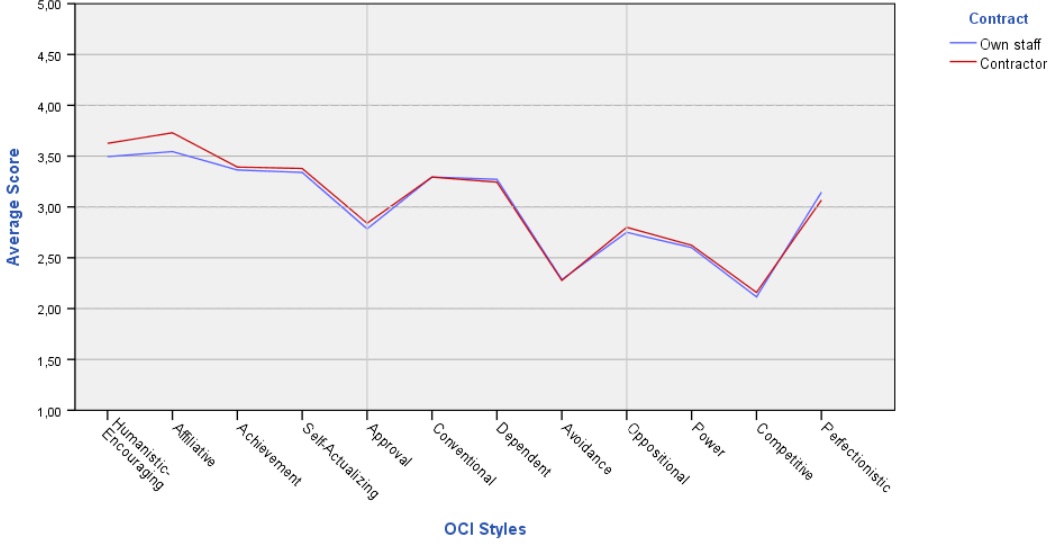
Figure 9. OCI styles averages by contractual relationship.